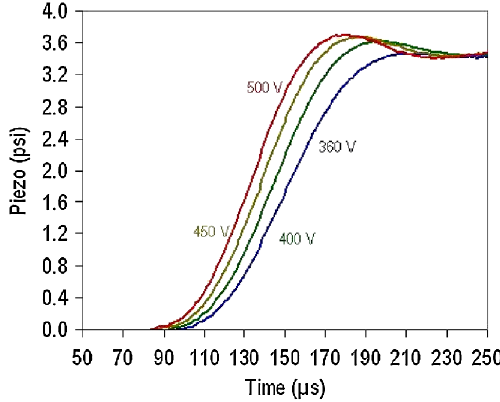
current).FIG. 11. Flyer-plate motion and measured piezopressure sig- nal (normalized, 3 mm from nozzle exit: 800 psia helium, 350 V charge).